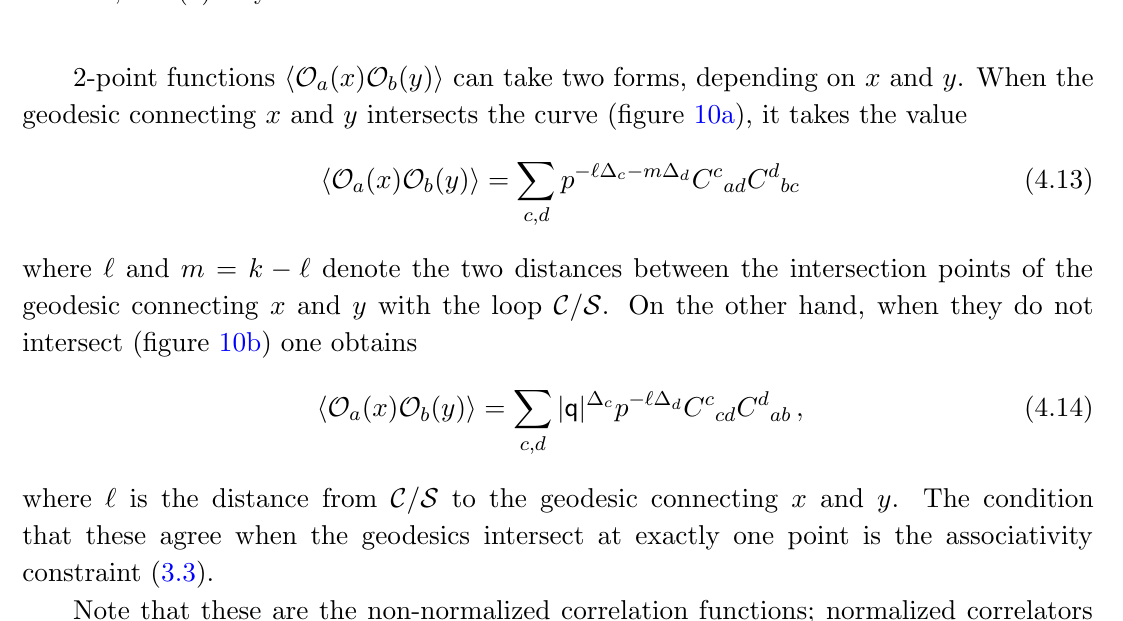
Figure 10. 2-point function in the cases where (a) the geodesic and the torus’ minimal curve intersect, and (b) they do